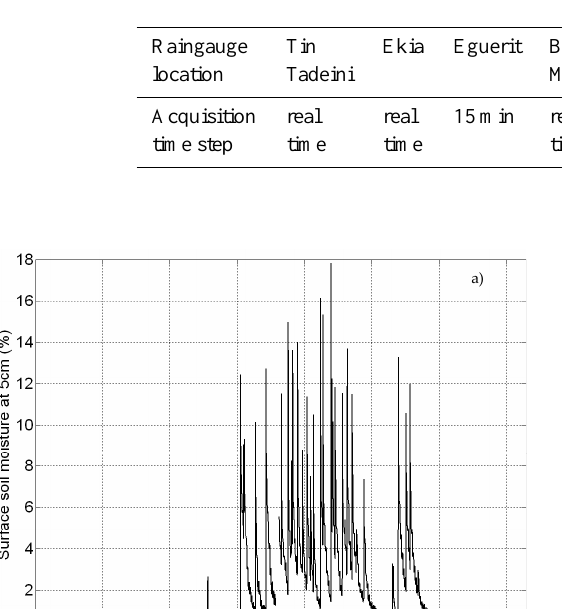
Table 1. Raingauges acquisitions time step.